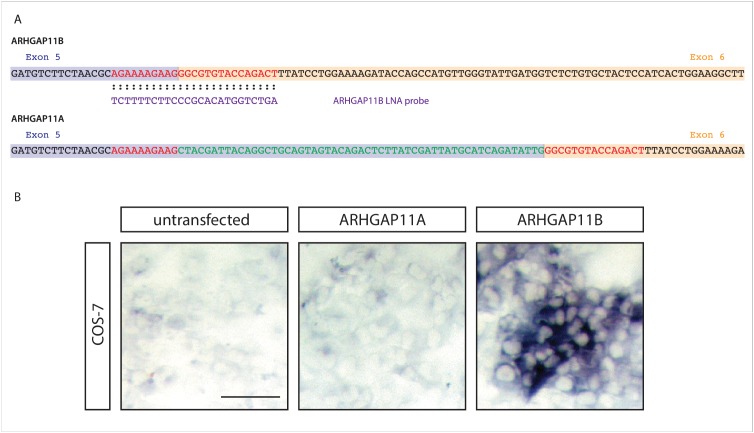
ARHGAP11B-specific ISH probe.(A) Nucleotide sequences at the exon 5 (purple background) – exon 6 (orange background) junction of the ARHGAP11B (top) and ARHGAP11A (bottom) mRNAs (note that U is depicted as T). The ARHGAP11B LNA ISH probe shown in violet is complementary to the nucleotides shown in red. The 55 nucleotides shown in green are unique to the 3'-end of the ARHGAP11A exon 5 and interfere with the binding of the LNA ISH probe to the ARHGAP11A mRNA, rendering the probe ARHGAP11B-specific. (B) Images of COS-7 cells that were either untransfected, or transfected with either an ARHGAP11A- or ARHGAP11B-expressing construct and stained with the ARHGAP11B LNA ISH probe. Note that an ISH signal is detected only in ARHGAP11B-transfected COS-7 cells, confirming the specificity of the LNA ISH probe for ARHGAP11B. Scale bar, 50 µm.